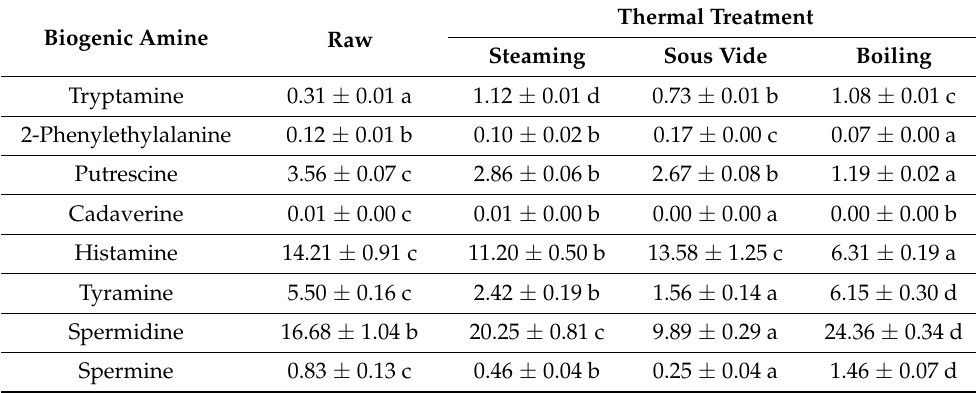
Table 3. Concentration of biogenic amines in raw and thermally treated Brussels sprouts (mg/kg d.m.). Biogenic Amine Raw